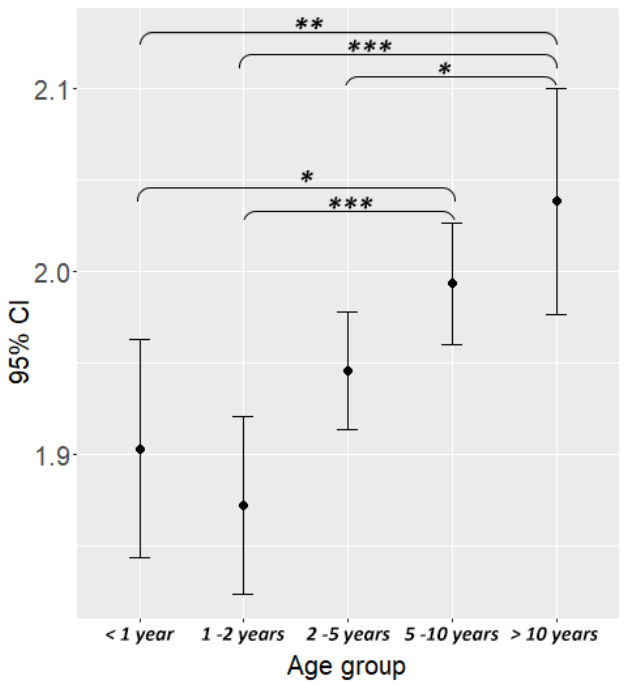
Figure 1. Dogs’ age had a significant association with body condition: dogs in the oldest age group (>10 years) were more likely to be obese than dogs in the first three age groups and dogs in the fourth age group (between 5–10 years) were more likely to be obese than dogs in the first two age groups. Asterisks indicate level of significance: * p < 0.05; ** p < 0.01; *** p < 0.001.